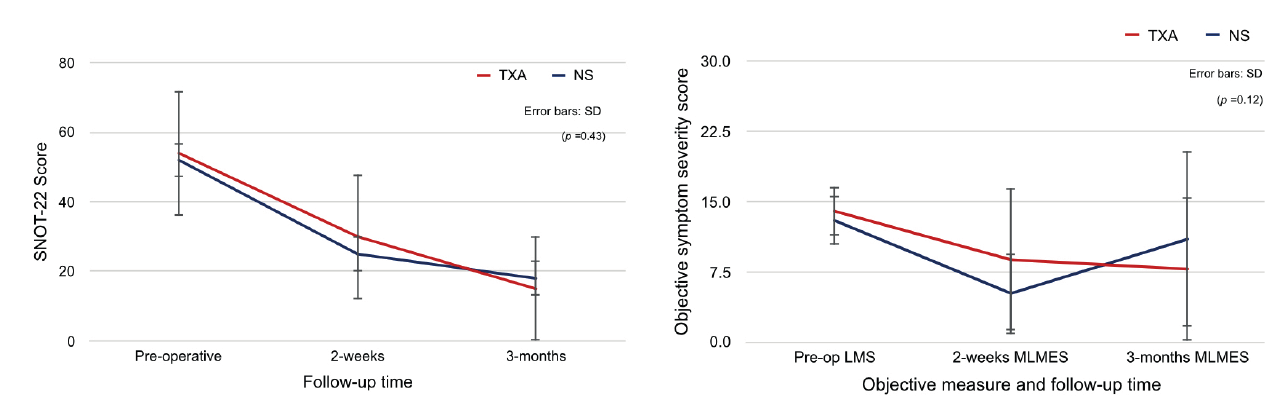
18.8 compared to 3-month score of 18.4 ± 14.9. (Please refer to Figure 3 for a comparison). The absolute reduction between the two time points was therefore lower at 33.4 points (24.0, 42.9). However, one-way ANOVA found the mean difference (95% CI) of 6.04 (-9.12, 21.2) points between the experimental arms non-significant (p=0.42). Furthermore, Mixed Between-Within Subjects ANOVA showed that the SNOT-22 scores for TXA did not differ significantly to NS across any of the follow-up time points (p=0.43).